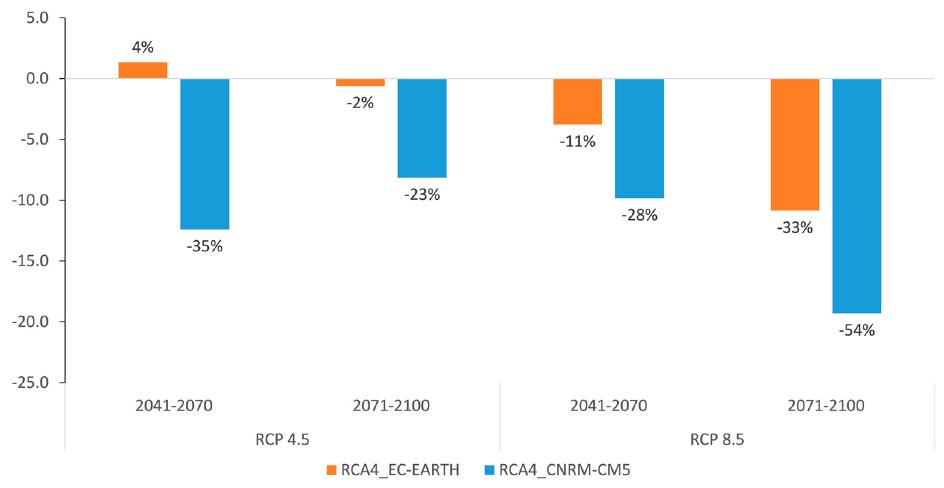
Figure 5. Annual streamflow change in the medium term (2041–2070) and the long term (2071–2100).